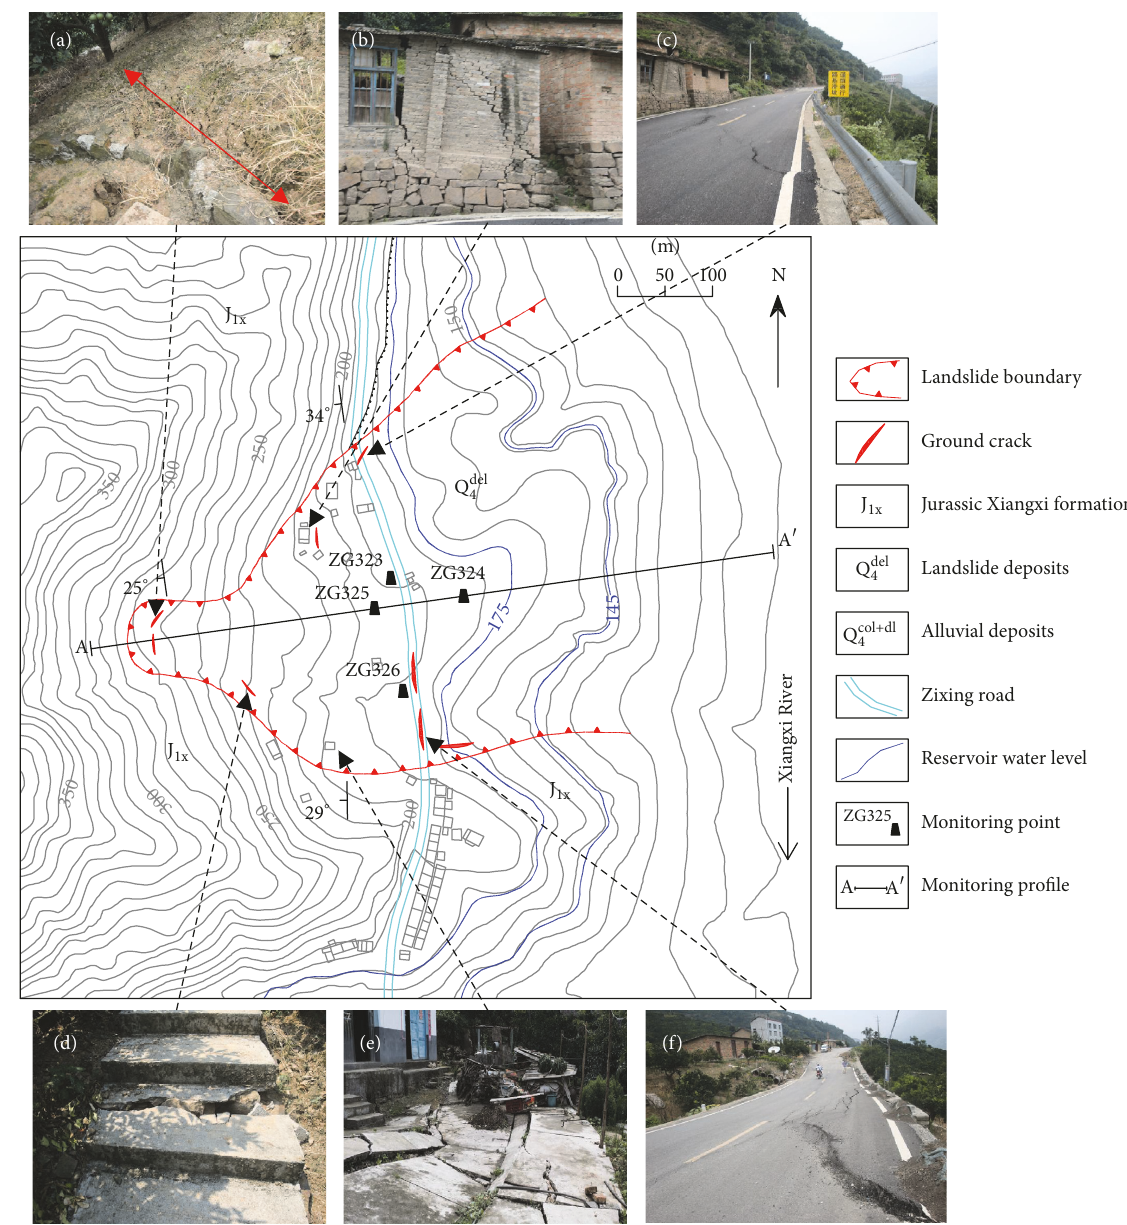
Figure 3: Geological plan of Baijiabao landslide, with the locations of deformations and monitoring